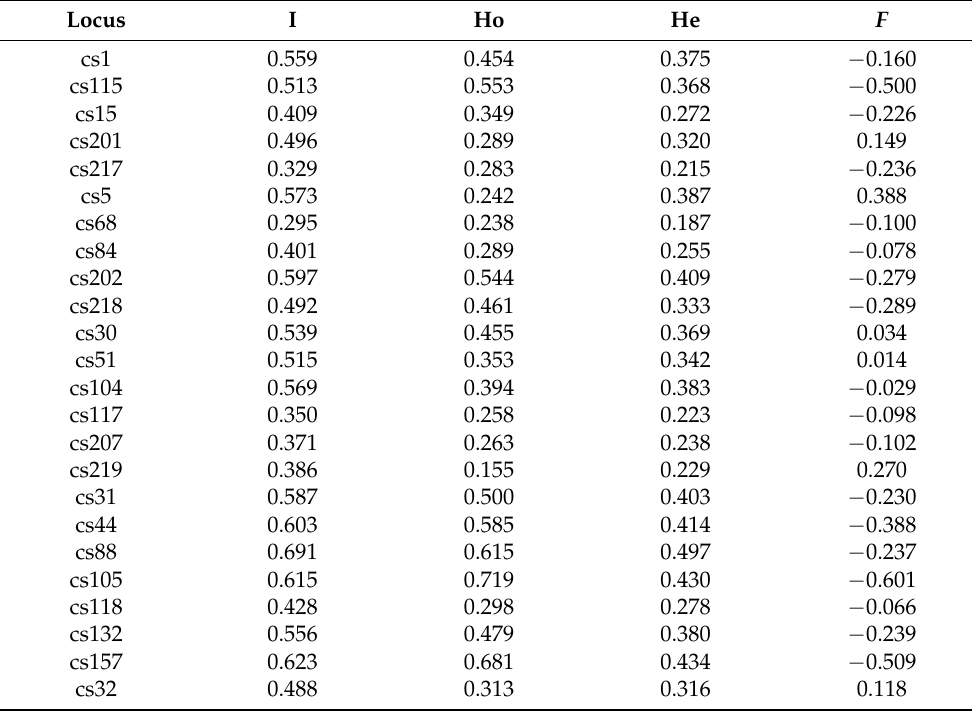
Table 2. Allele information of 47 polymorphic SNP